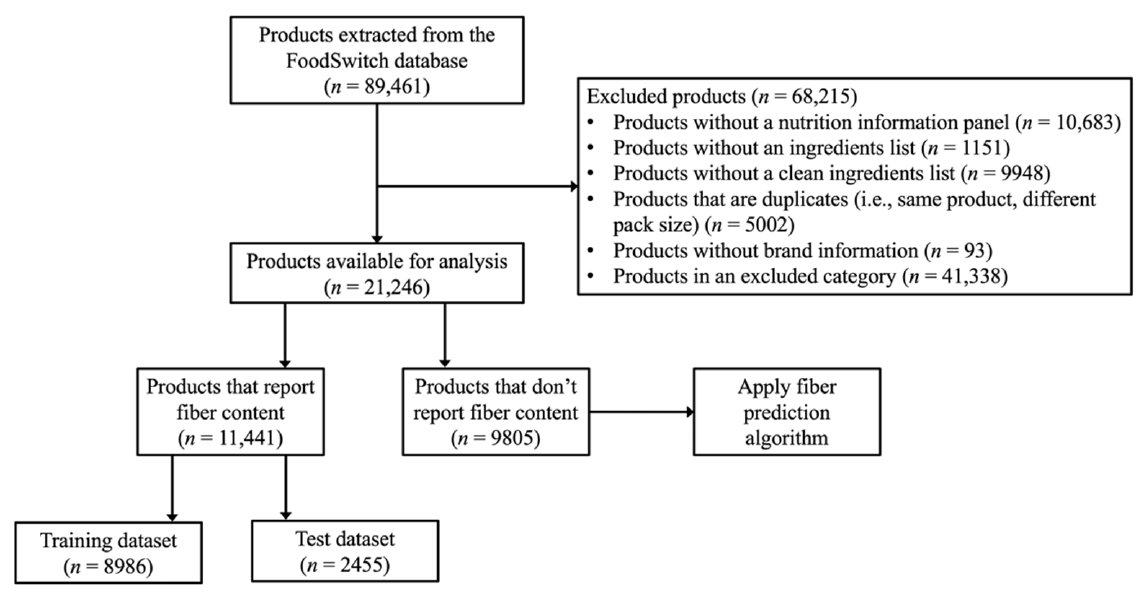
Figure 1. Exclusion criteria and data preparation flow chart.